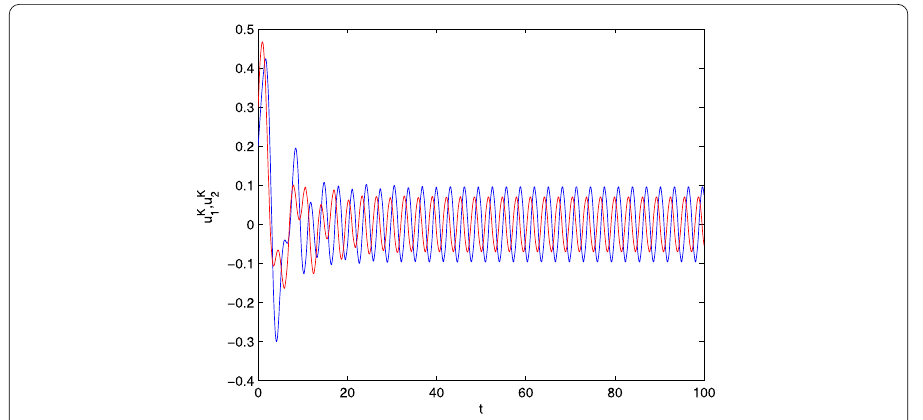
Figure 4 The anti-periodic solution of model (5.1): t – u K 1 and t – u K 2 . The blue line stands for u K 1 and the red line stands for u K